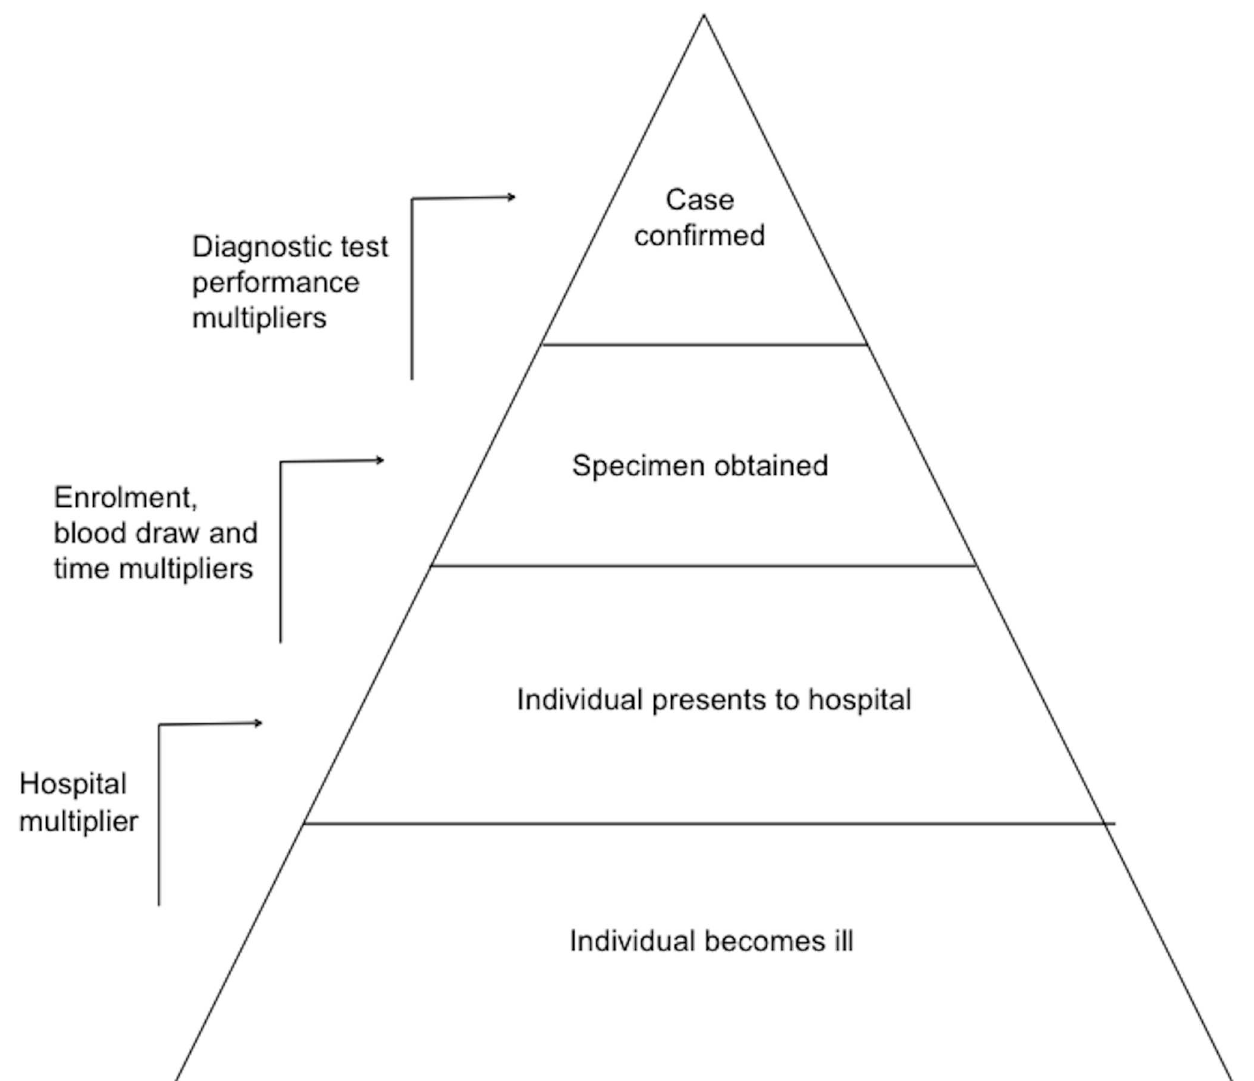
Fig 1. Surveillance pyramid showing multipliers used to account for incomplete case identification. Modifiedfrom Biggs HM, Hertz JT, Munishi OM, GallowayRL, Marks F, SagandaW, et al. Estimating leptospirosisincidenceusing hospital-based surveillance and a population- based health care utilizationsurvey in Tanzania. PLoS Negl Trop Dis. 2013;7(12):e2589.